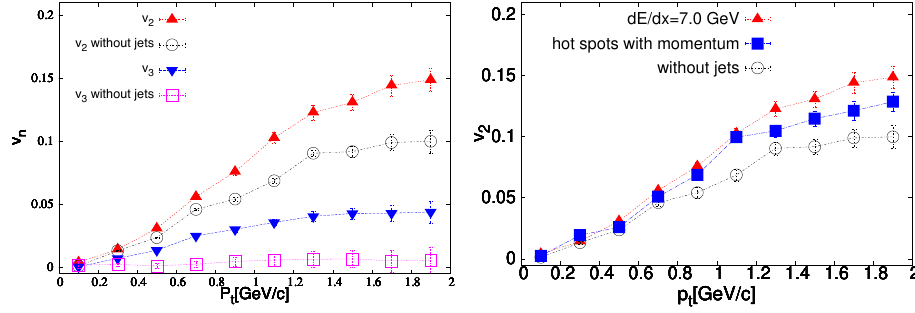
Figure 1. Anisotropic flow coe ffi cients generated by momentum deposition from hard partons in cen- trality class 30–40%. Left: v 2 and v 3 from simulations with momentum deposition and without it, only with smooth initial conditions (“without jets”). Right: The curve with squares shows results from a simulation with no momentum deposition from hard partons, but with the same amount of momentum and energy anisotropies superimposed on the smooth initial energy density profile in the form of hot